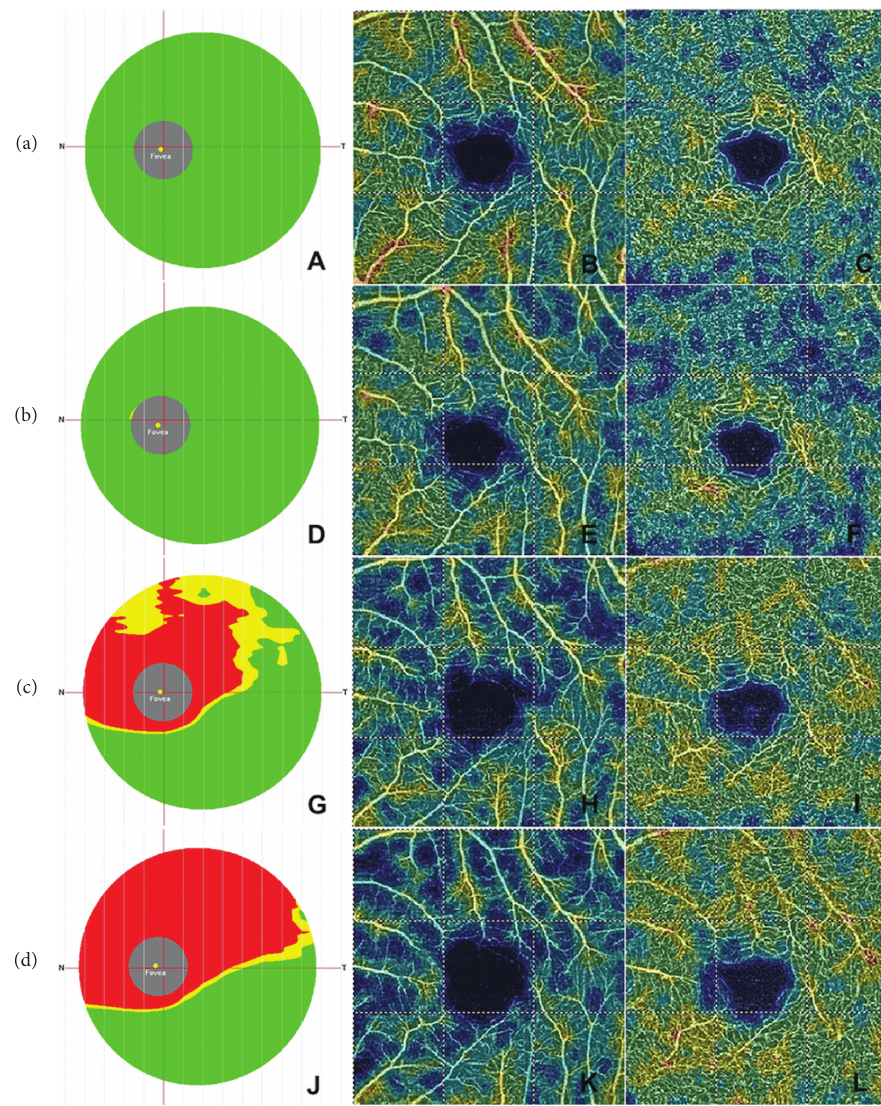
Figure 2: The time course of structural OCTand Angio-OCT findings in macular retina in the same patient in Figure 1 ((a) baseline, A ∼ C; (b) 1 ∼ 2w, D ∼ F; (c) 1 ∼ 2m, G ∼ I; (d) 3 ∼ 6m, J ∼ L). The GCC thickness reference map (A, D, G, J) showed a significant decrease of the thickness of the GCC at 1 ∼ 2m (G) and 3 ∼ 6m (J) follow-ups compared to those at the initial visit (A) and 1 ∼ 2w follow-up (D), as the increasing areas of red or yellow color shown in the map. The superficial vessel density map of Angio-Retina 3.0mm (B, E, H, K) showed the reduction of SVD, which became sever with the time progress. The deep vessel density map of Angio-Retina 3.0mm (C, F, I, L) showed that DVD decreased at the initial visit (C) and 1 ∼ 2w follow-up (F), while there was slight increase of DVD at 1 ∼ 2m (I) and 3 ∼ 6m (L) follow-ups. GCC, ganglion cell complex; SVD, superficial vessel density; DVD, deep vessel